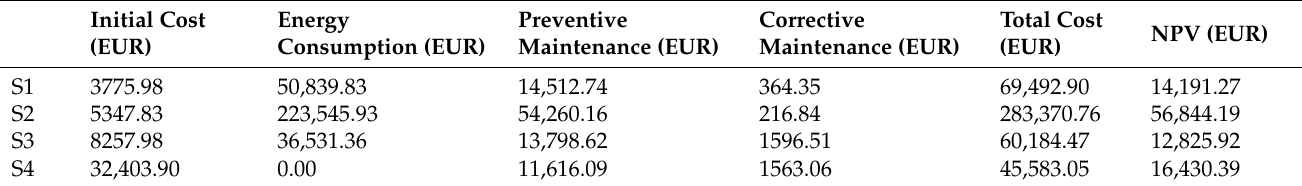
Table 8. Costs of lighting life cycle scenarios.